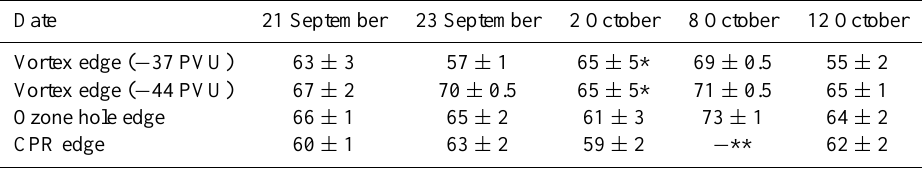
Table 1. Comparison of vortex edge latitude, from the ECMWF analyses, ozone hole outer edge latitude from TOMS data, and CPR latitude from in-situ measurements. The vortex edge in the ECMWF analysis is taken to be the latitude of the − 37 PVU or − 44 PVU contour in the 45–75 ◦ W sector. The ozone hole outer edge latitude is taken to be the latitude of the 225 DU contour in the 45–75 ◦ W sector. The uncertainty in the CPR latitude reflects the width of the region with rapidly increasing ozone on the return flight leg.